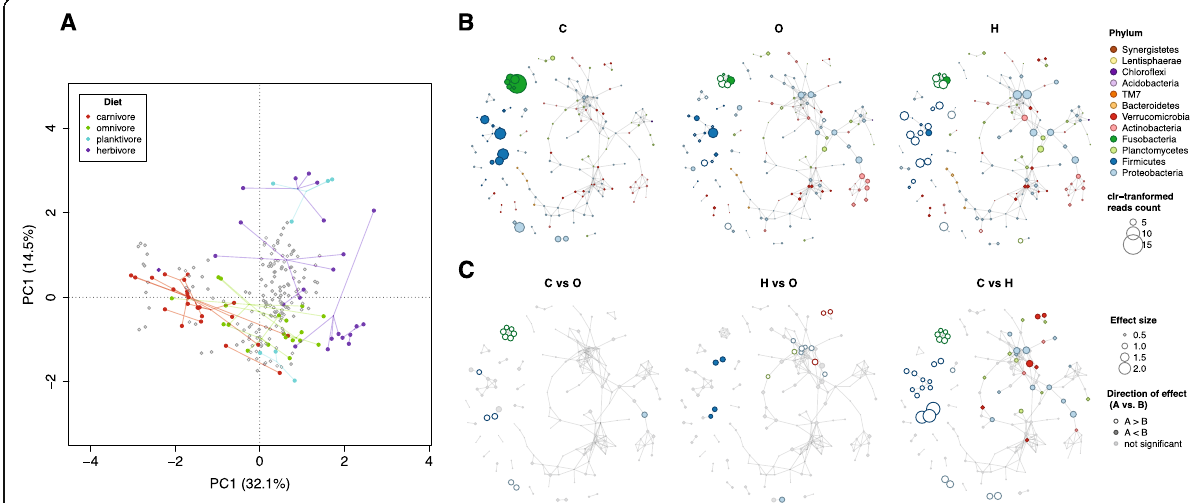
Fig. 5 Mapping of diet contribution onto L. Tanganyika network. a Principal components analysis (PCA) of centered log-ratio (clr) transformed OTU counts for the Lake Tanganyika network. The PCA biplot shows both samples (i.e. individual fish, colored by diet), and OTUs (grey circles). Sample OTUs are grouped by cichlid species, as indicated by spider plots (lines connecting group samples to group centroid). The OTU coordinates in the PCA were used as a template to produce the network layout shown on panels b and c , as explained in the Methods. b Tanganyika network showing median node abundances for carnivorous (C), omnivorous (O) and herbivorous (H) diet. Node size is proportional to the median OTU abundance (after clr transformation) across individual specimens within each diet. Filled circles correspond to nodes with abundance above the geometric mean, whereas hollow circles indicate nodes with abundance below the geometric mean. c Tanganyika network showing node effect sizes for t-test pairwise comparisons between diets (estimated with ALDEx2). Nodes that significantly discriminated between diets ( p <0.05) are colored to phylum level, as in b . Hollow circles indicate nodes that tend to be relatively more abundant in the left-hand diet of the contrasted pair (e.g. C in C vs H), whereas filled circles show nodes that tend to be more abundant in the right-hand diet (e.g. H in C vs. H). Grey nodes were not significant